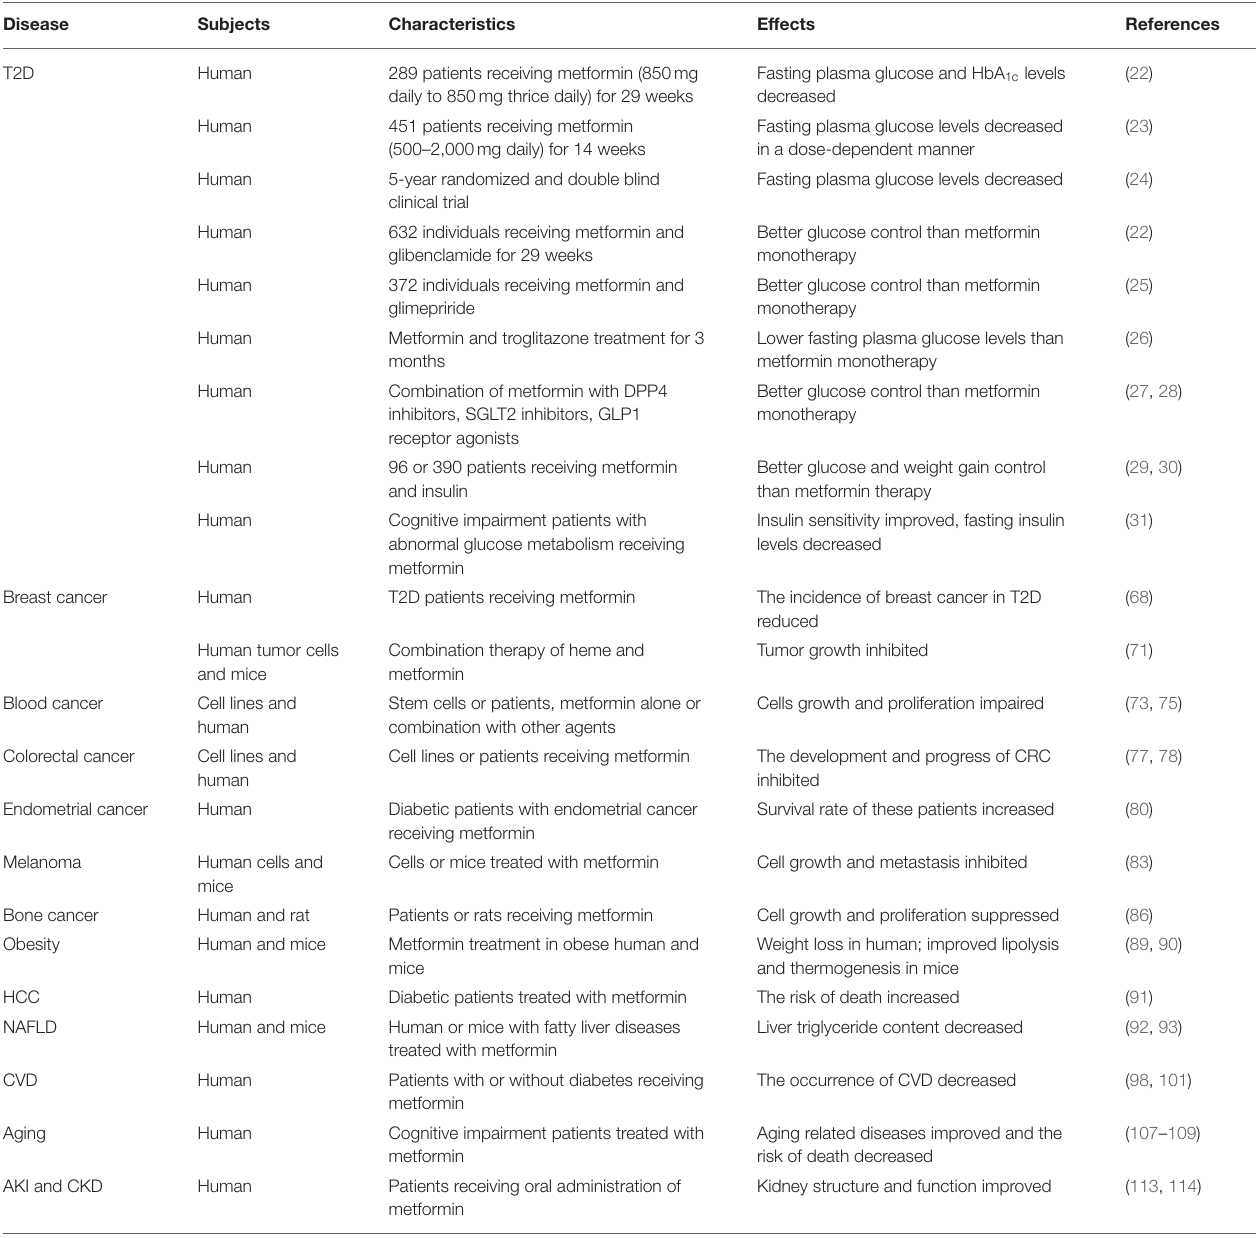
TABLE 1 | Beneficial effects of metformin on